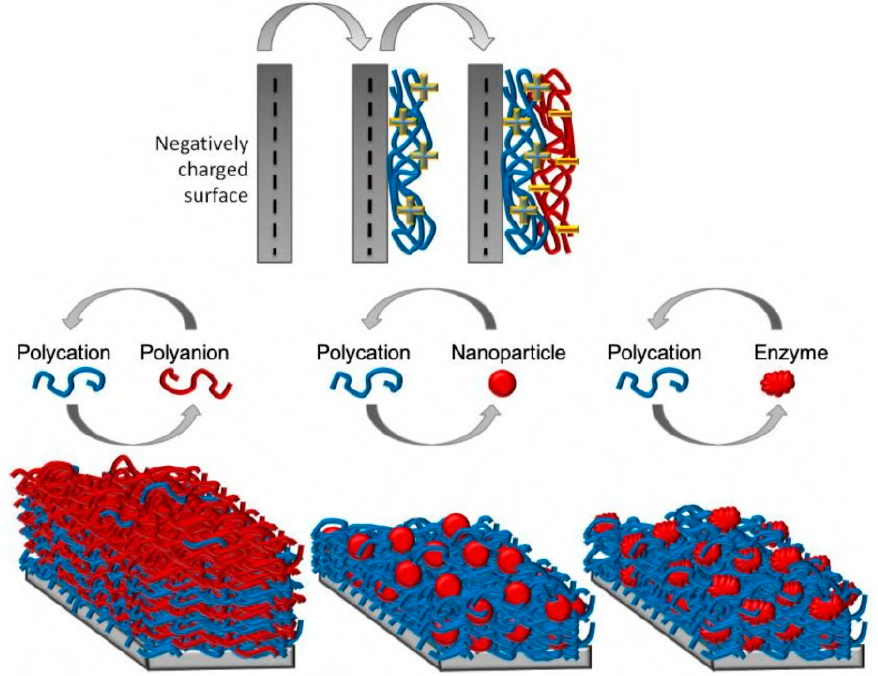
Figure 12. Layer-by-layer coating technique. Positive and negative charge molecules are adsorbed one after the other on the surface, and this cycle continues n times to obtain the desired film thickness (reprinted with permission from Escobar et al., 2021 [142]).